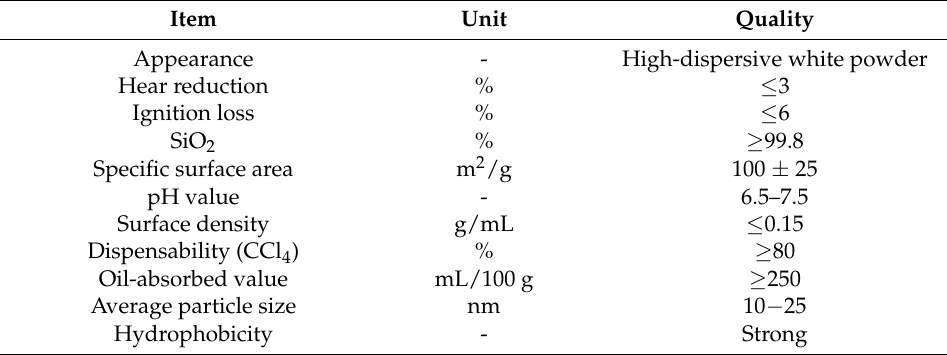
Table 2. Nano-silica